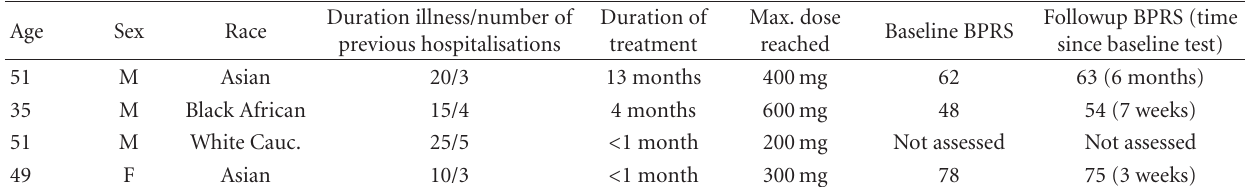
Table 3: Those 4 patients who stopped Melperone as it is considered “ine ff